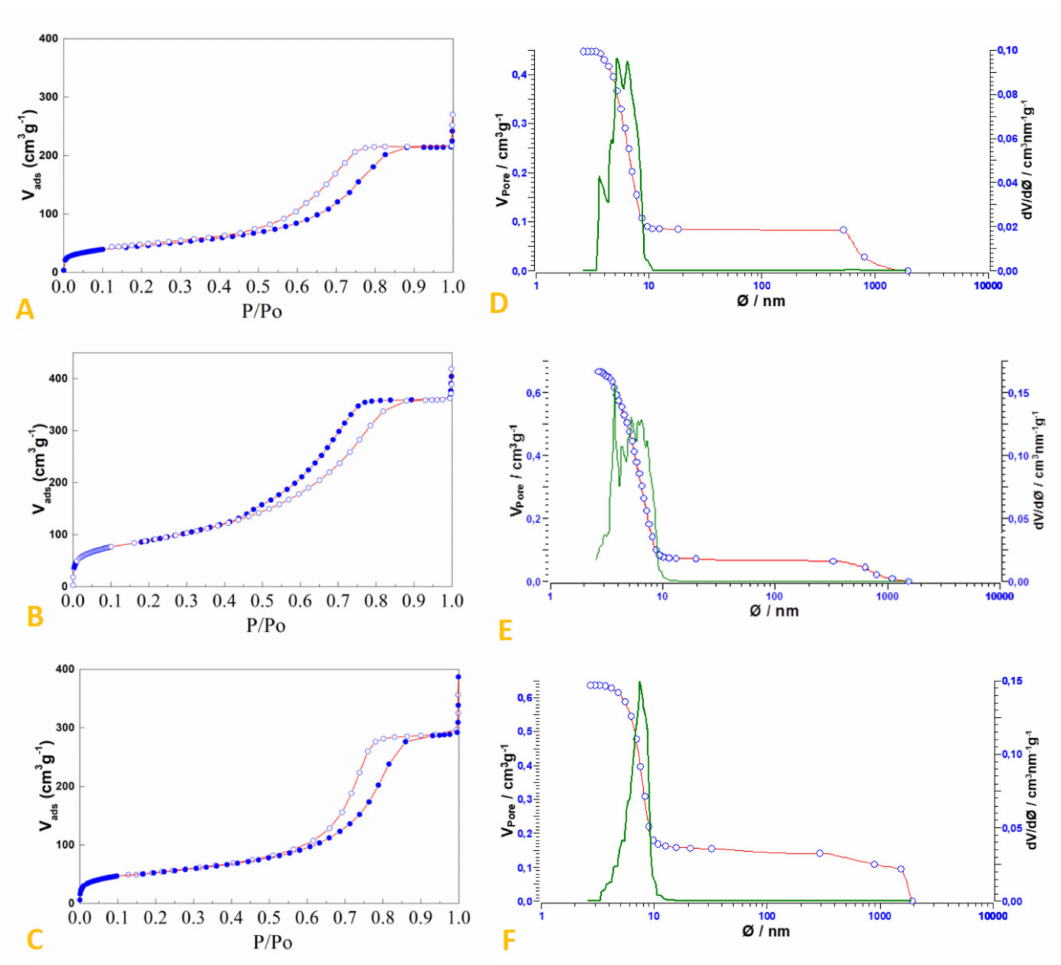
Figure 4. N 2 physisorption isotherms and the corresponding pore size distribution of ( A ), ( D ) NH 4 HSO 4 -SiO 2 , ( B ), ( E ) HCl.Gly-SiO 2 and ( C ), ( F ) NH 4 Br-SiO 2